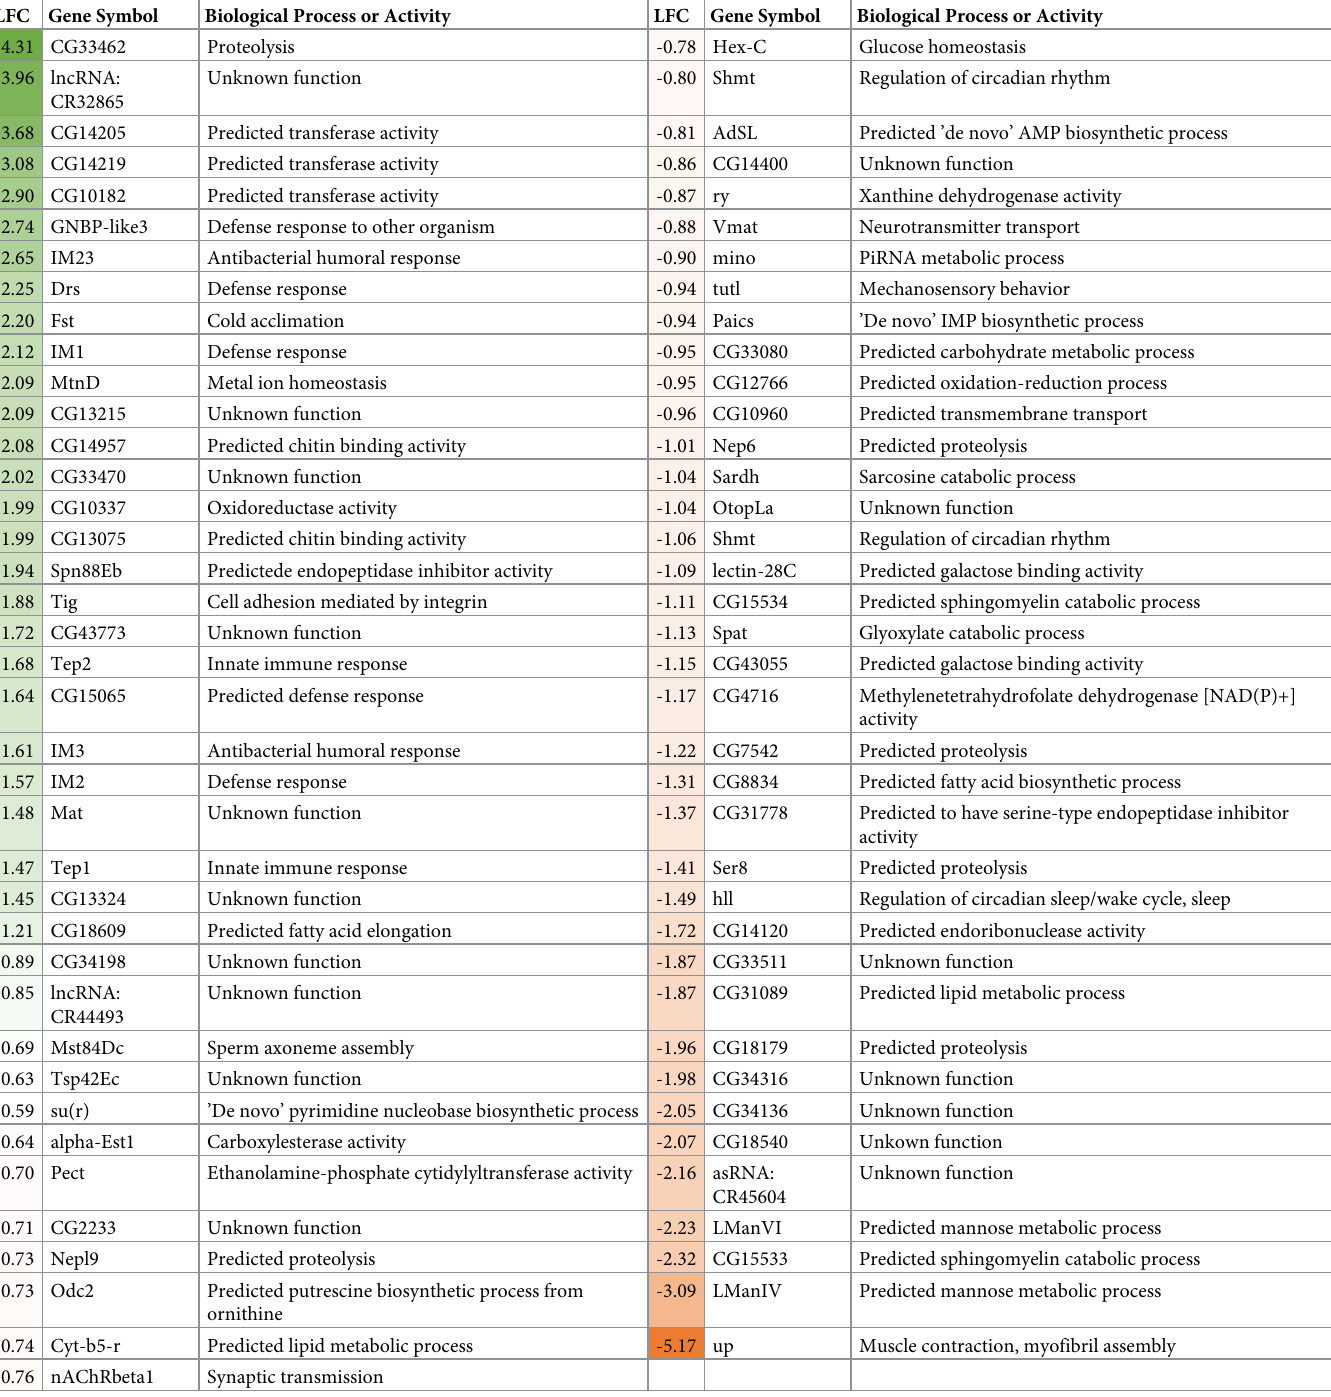
Table 2. Differentially expressed genes of the LB-flies vs. the NB-flies and corresponding biological processes or an activity based on the FlyBase annotation (FB2020_04 release). FDR < 0.05, LFC—Log 2 fold